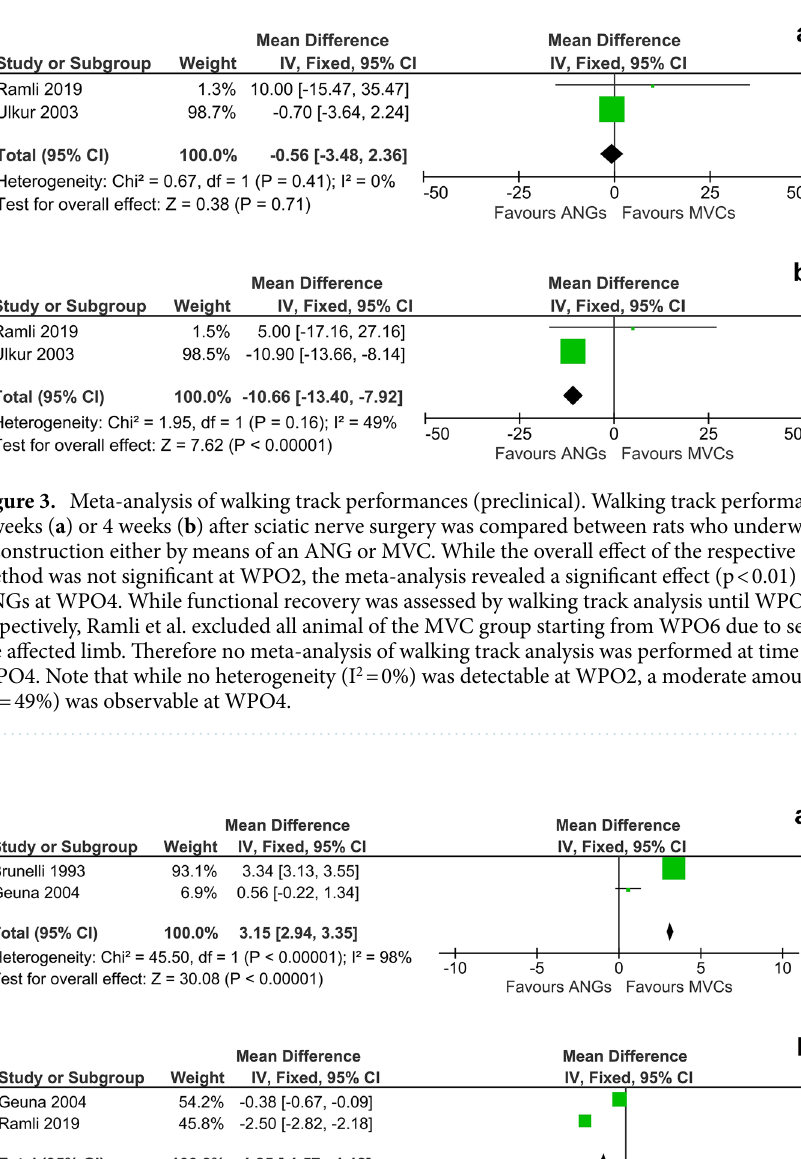
proteases and have a markedly increased proteome turnover in comparison to humans 47 . This is thought to be related to their shorter lifespan with their body optimized to quickly regain optimal integrity and function rather than maintaining the body over a long time 48 . We therefore hypothesize, that muscle fibers inside MVCs are degraded markedly faster in rodents than in humans, contributing to the inferior results of MVC nerve repair in murine models. As human proteome turnover is slower, muscle fibers inside the MVC persist longer, allowing more time for axons to transverse the MVC before it collapses. These profound differences impair clinical translation of results in rodent studies of peripheral nerve repair, especially in regard to critical size defects. However, critical size nerve defects represent a common clinical problem with a high need for adequate treatment options 38,39 . Out of the eight preclinical studies included in this work, three featured a critical size nerve defect. Two of these studies were published within the last 3 years and